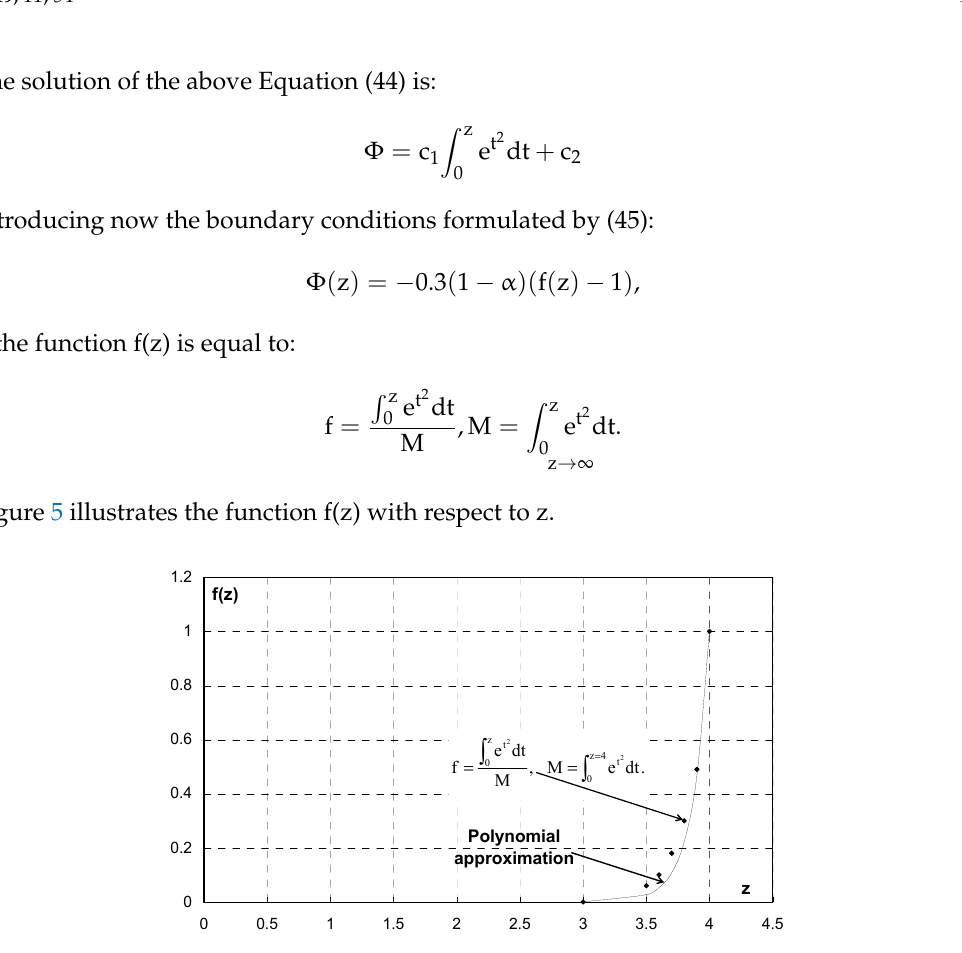
Figure 5. Function f(z) with respect to z.